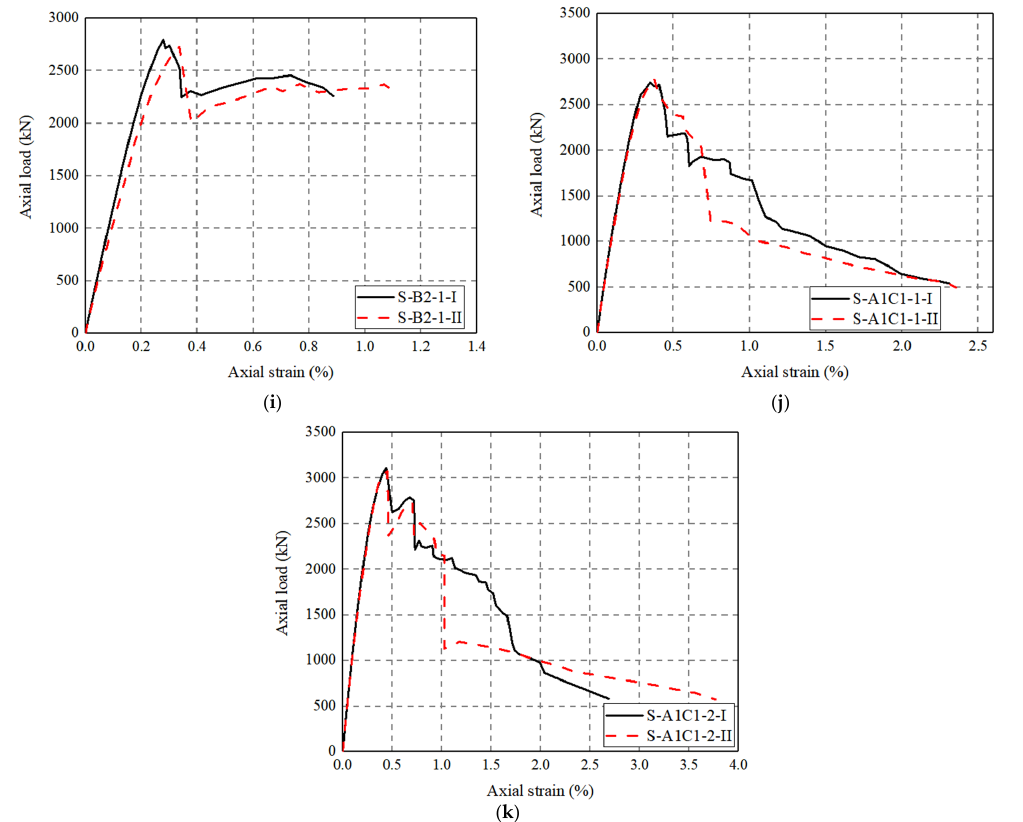
Figure 10. Axial load–axial strain curves of test columns. ( a ) H-L0-0; ( b ) H-A2-0; ( c ) H-B1-0-; ( d ) H-B2-0-; ( e ) H-A1C1-0-; ( f ) S-A2-0-; ( g ) S-B2-0-; ( h ) S-A1C1-0-; ( i ) S-B2-1-; ( j ) S-A1C1-1-; ( k ) S-A1C1-2-.